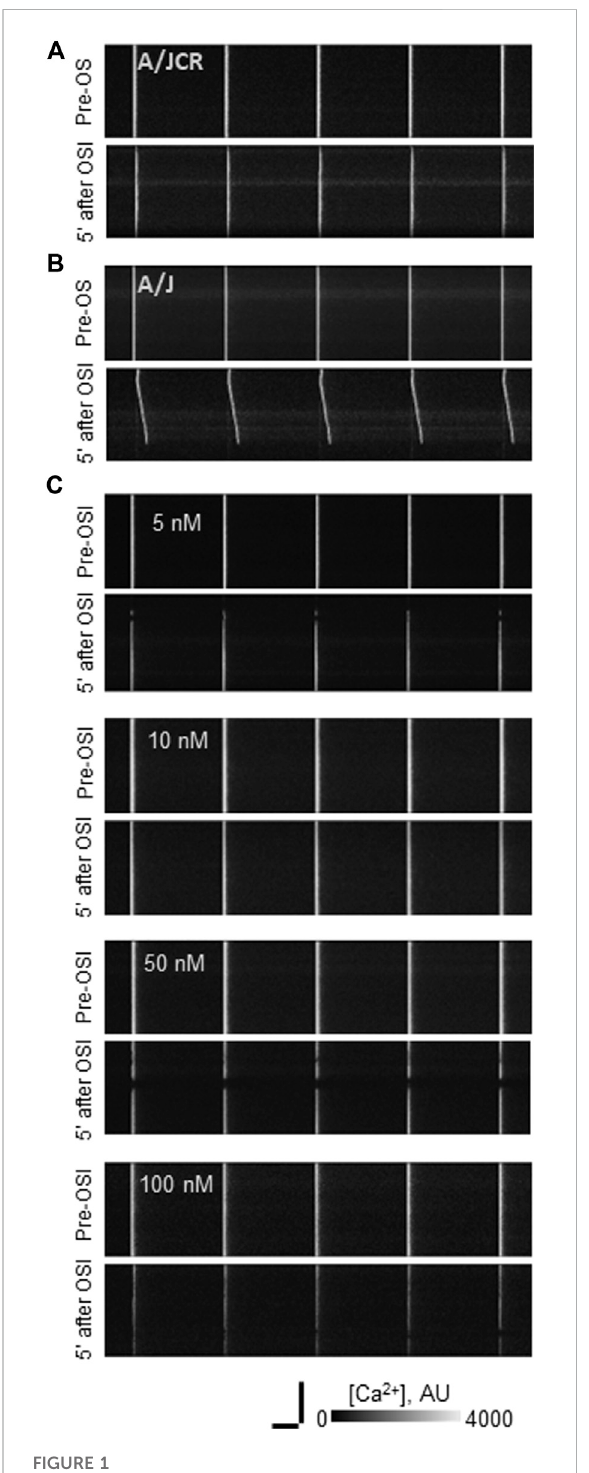
FIGURE 1 EffectofosmoticshockinjuryonCa 2+ transientsinFDB fi bers preloaded with different concentrations of BAPTA-AM. A/J or A/ JCr myo fi bers were loaded with Rhod-2AM, with or without additional BAPTA-AM, subjected to 1 Hz stimulation, and imaged in line-scan mode under confocal optics (see Methods). Representative line-scan confocal images of